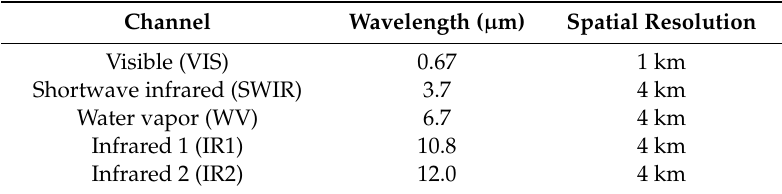
Table 2. COMS MI channel information